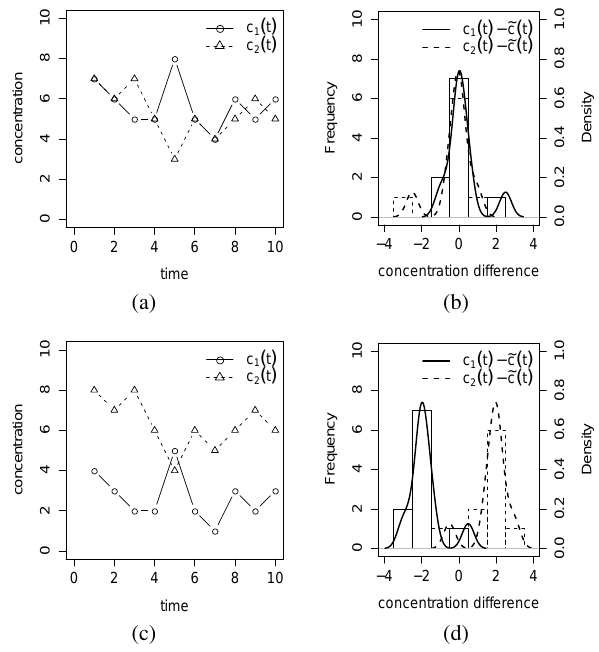
Fig. 2. Hypothetical concentration time series c 1 ( t ) and c 2 ( t ) with time t ∈ [1 , 10] (a,c) , and corresponding frequency and density dis- tributions of concentration differences c i ( t ) − ˜ c ( t ) (b,d) for mixed conditions (a,b) and for non mixed conditions (c,d). Regarding the density distributions in Subfig. (b) and (d), the histogram bars in- dicate the frequency for binwidths of 1.0, the solid line is a kernel density estimation generated with the same tools which were used for density estimation of measured concentration data as described in Sect.2.7.